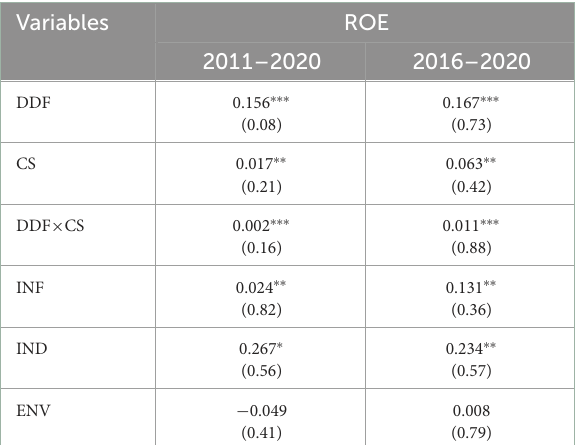
TABLE 8 Robustness